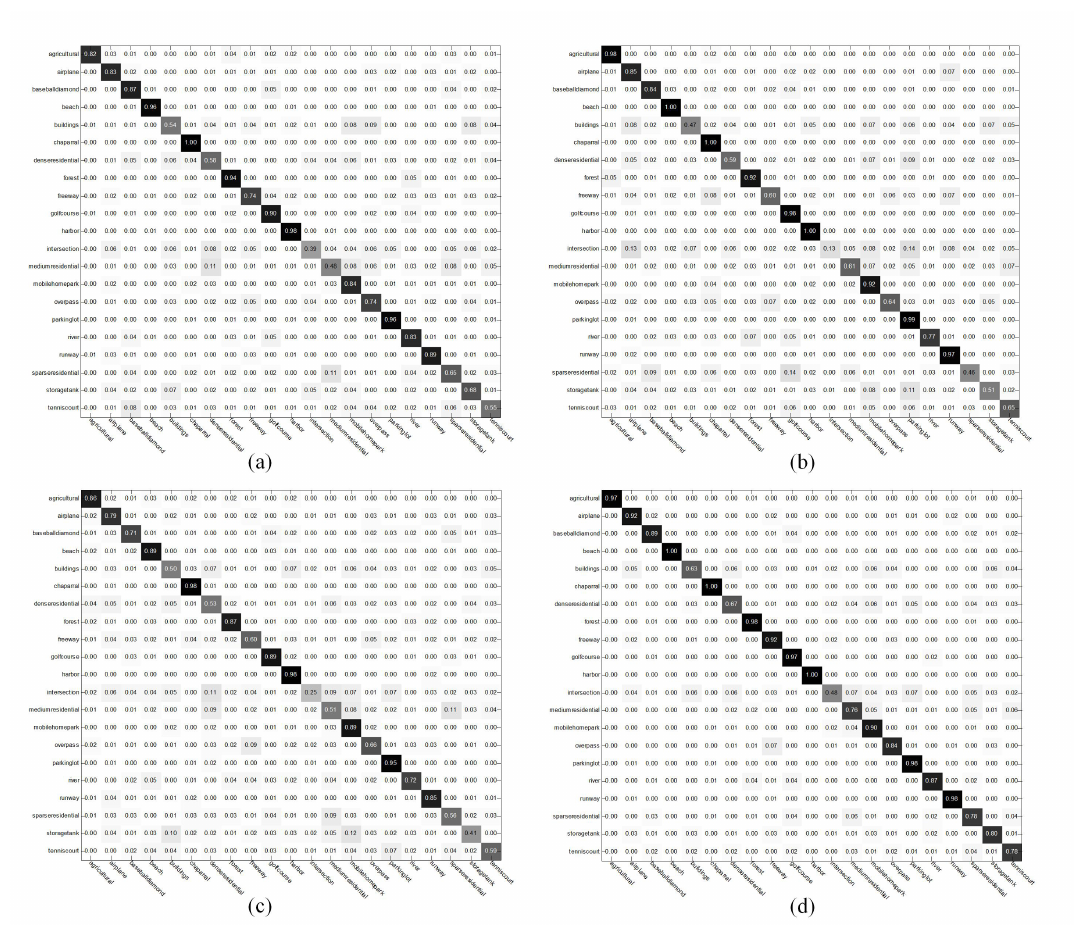
Figure 10. The average confusion matrices of: ( a ) baseline Method 1; ( b ) baseline Method 2; ( c ) baseline Method 3; and ( d ) the proposed